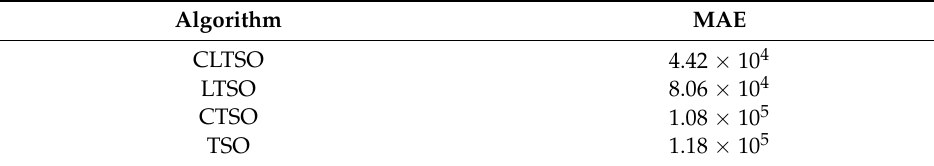
Table 13. MAE ranking results.